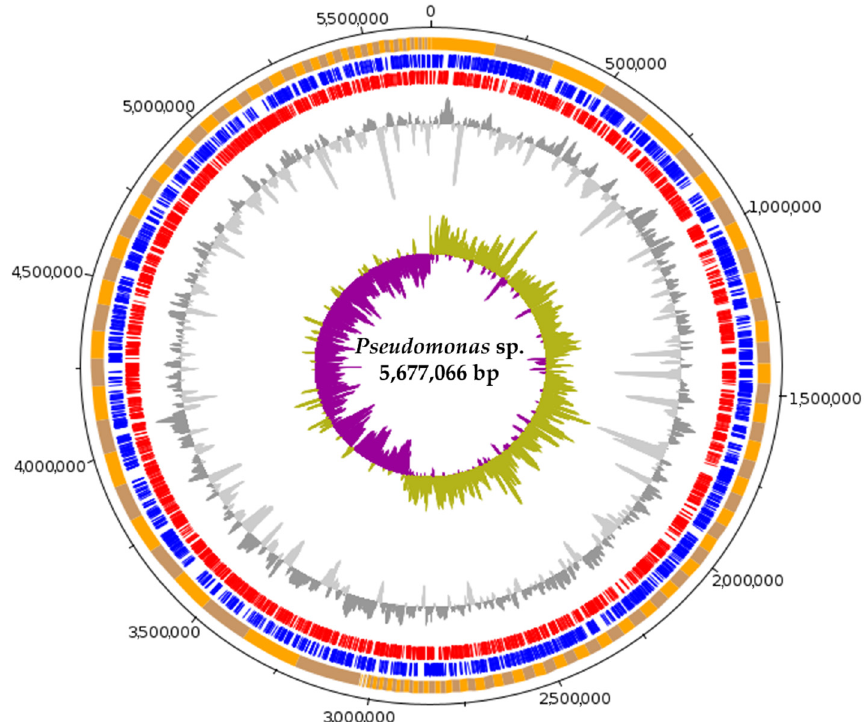
Figure 1. Whole-genome representation of Pseudomonas sp. strain C3 using DNAPlotter tool. Orange and gray represent scaffolds ordered by GC bias and length. Blue and red represent CDS in the forward and reverse directions, respectively. Gray represents GC content with respect to the mean. The innermost circle represents the GC bias with respect to the mean. Table 1. Molecular features that determine the genome of Pseudomonas sp. strain C3.